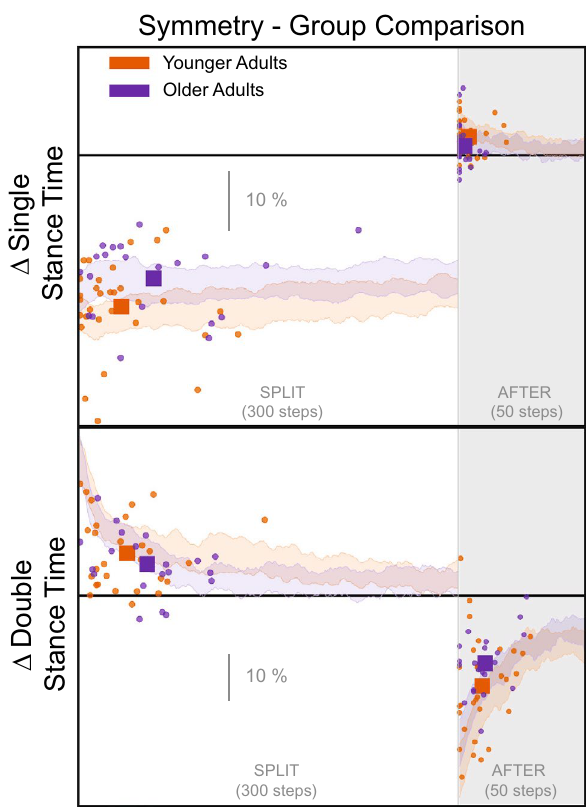
Figure 7. Temporal Gait parameters steps to plateau graphs for younger (orange) and older (purple) adults for split and after conditions. The small circles indicate single subject steps to plateau and the larger squares indicate the group average. The shaded area represents the 95% confidence interval for the group average symmetry. The thick black horizontal line indicates perfect